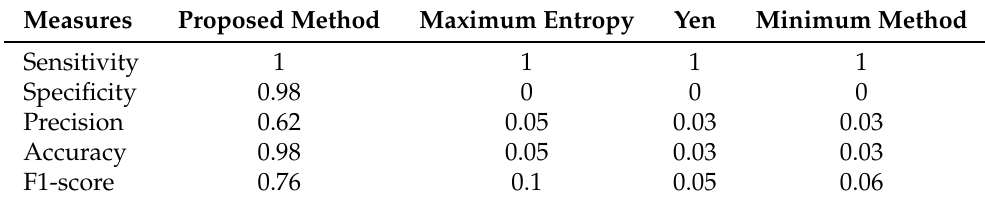
Table 3. Comparison of the performance factors of the proposed method with other selected methods— data set